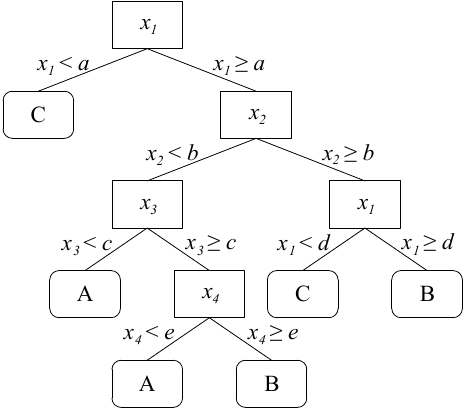
Figure 2. Sketch of a simple decision